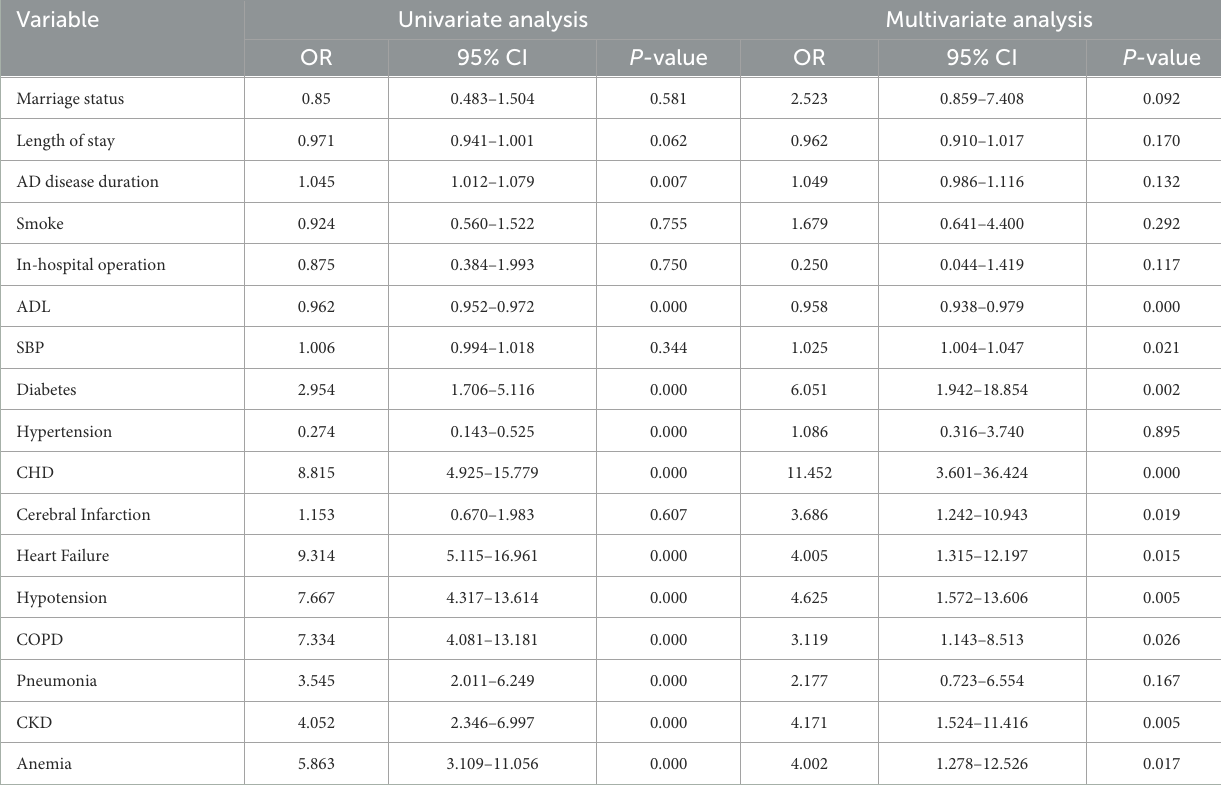
TABLE 3 Univariable and Multivariate logistic regression analysis for all-cause in-hospital